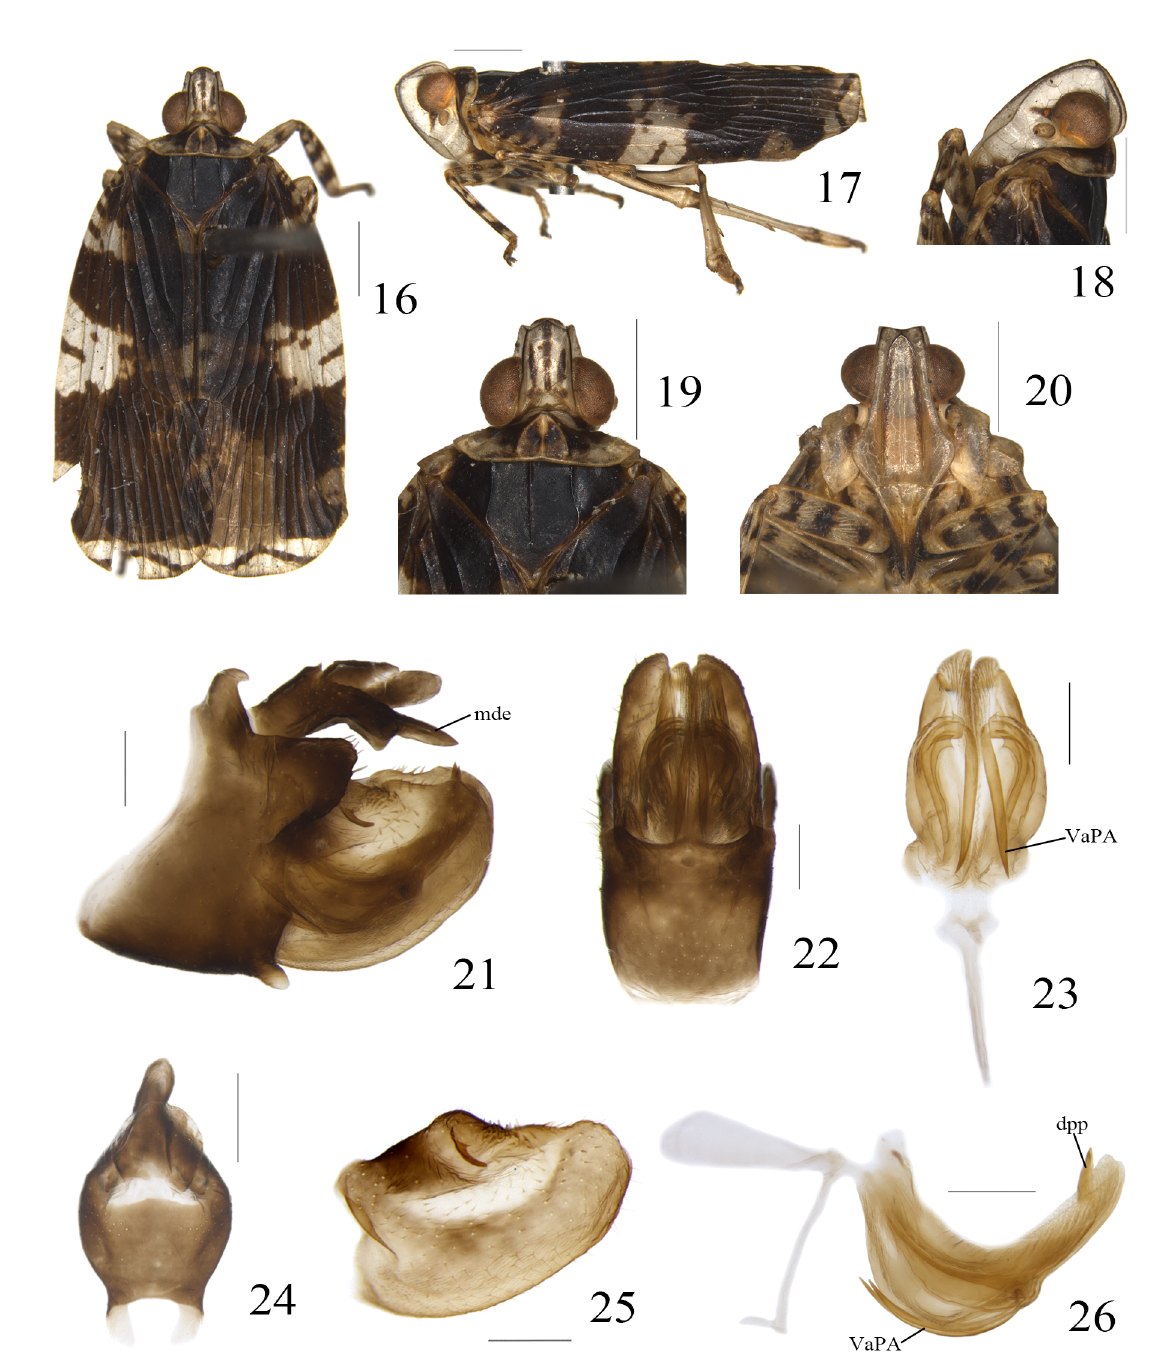
Figs 16–26. Pitambara impudica Wang & Bourgoin, sp. nov., holotype, ♂. 16 . Habitus, dorsal view. 17 . Habitus, lateral view. 18 . Head, lateral view. 19 . Head and thorax, dorsal view. 20 . Frons and clypeus. 21 . Male terminalia, lateral view. 22 . Male terminalia, ventral view. 23 . Phallic complex, ventral view. 24 . Anal tube, dorsal view. 25 . Gonostylus, lateral view. 26 . Phallic complex and tectiform structure, lateral view. Scale bars: 16–20 = 1 mm; 21–26 = 0.2